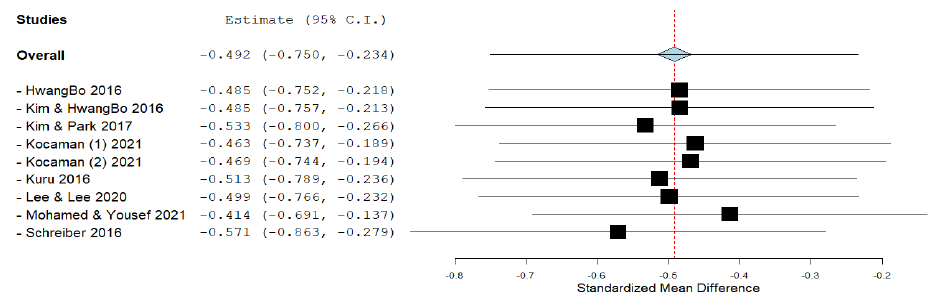
Figure 5. Leave ‐ one ‐ out analysis for the outcome Cobb angle.